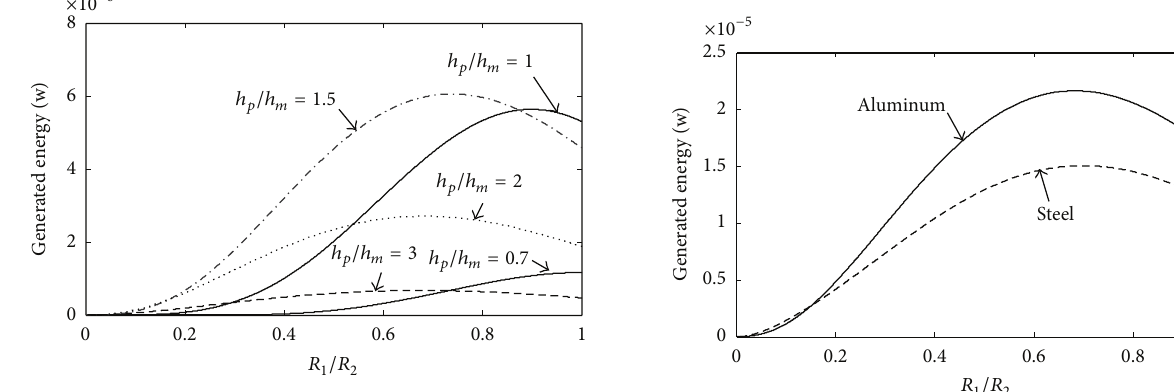
Figure 6: Effect of substrate material on generated energy with simple support conditions (Section